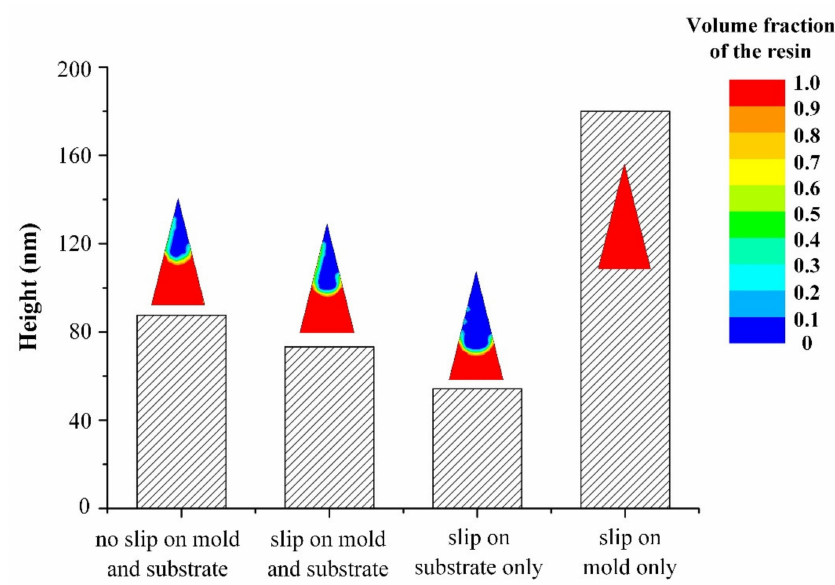
Figure 11. Effect of slip position on the filling height of moth-eye